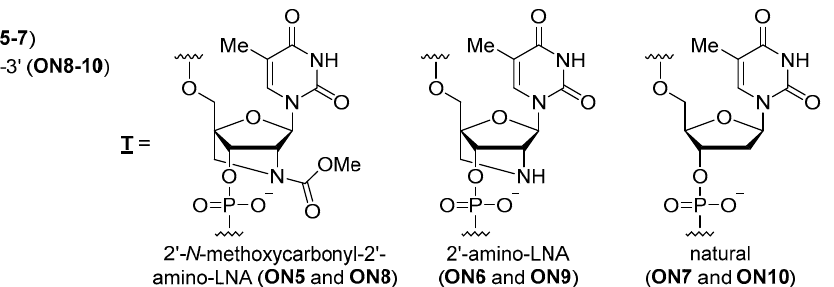
Figure 3. Oligonucleotides containing 2 ′ -(methoxycarbonyl)amino-LNA and 2 ′ -amino-LNA, and natural oligonucleotides used in this study.